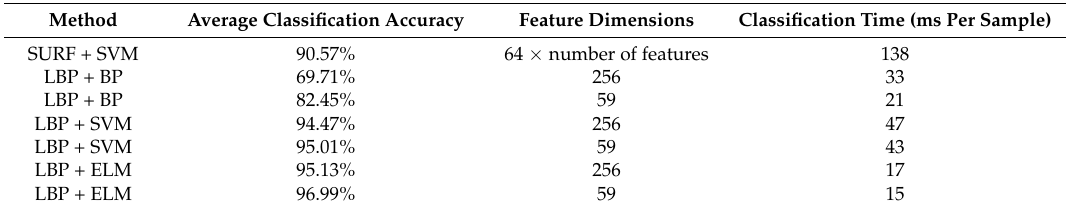
Comparison of the computation and classification performance among ELM and other